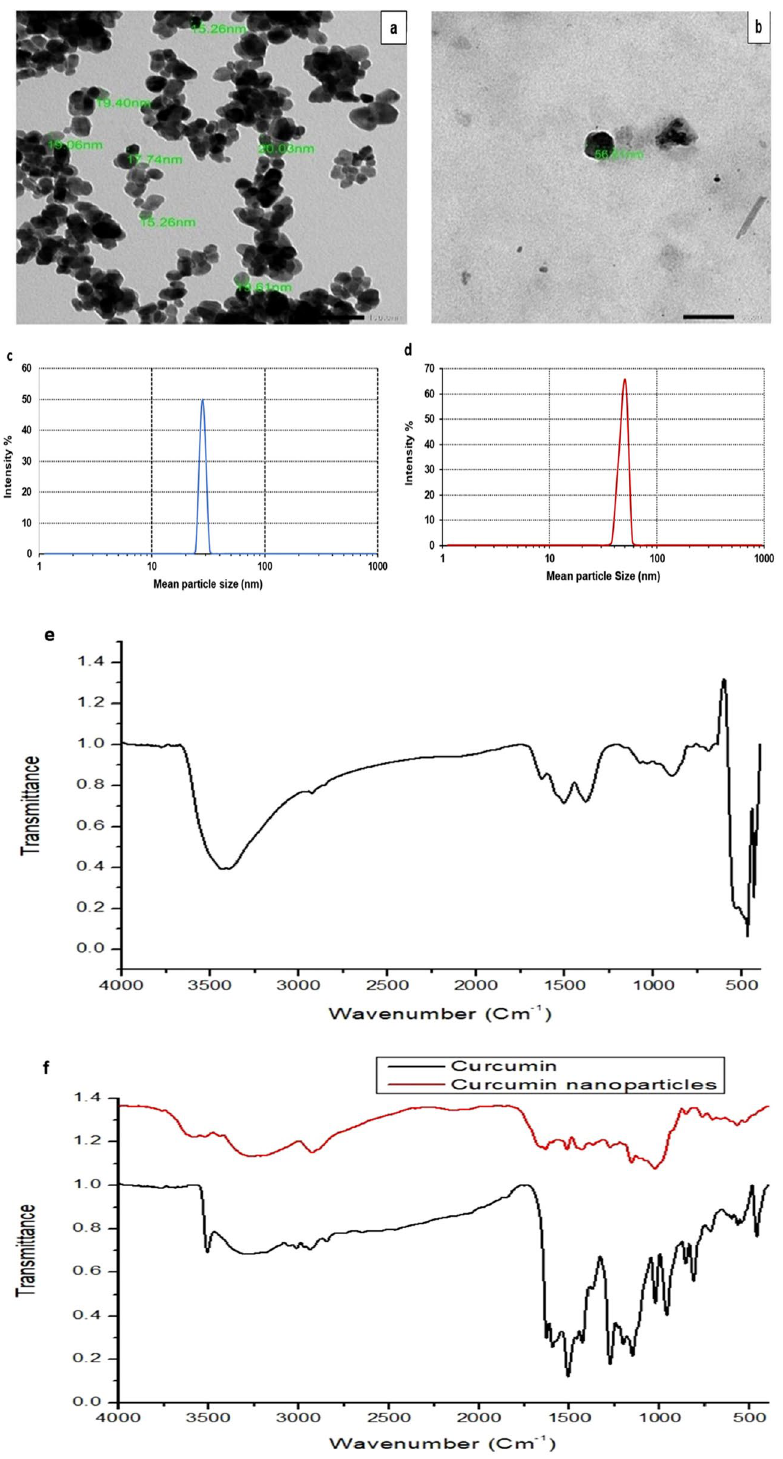
Figure 2. Characterization of prepared ZnONPs and CurNPs. ( a ) TEM analysis of ZnONPs; ( b ) TEM analysis of CurNPs; ( c ) Particle size of ZnONPs; ( d ) Particle size of CurNPs; ( e ) FTIR of ZnONPs and ( f ) FTIR of